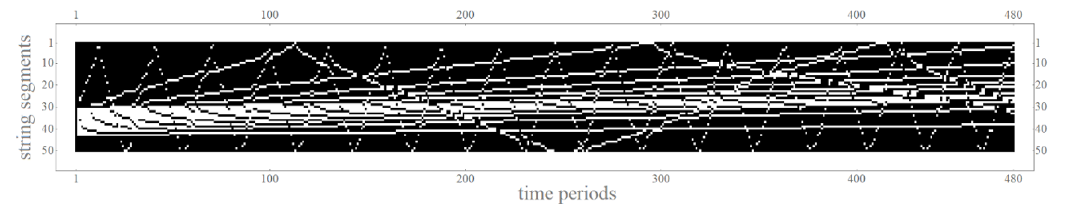
Figure 19 . Recurrence plot of cusps on the worldsheet. The parameters of the simulation are ∆ t = 8 , (cid:15) = 0 . 1 , N = 100 kink